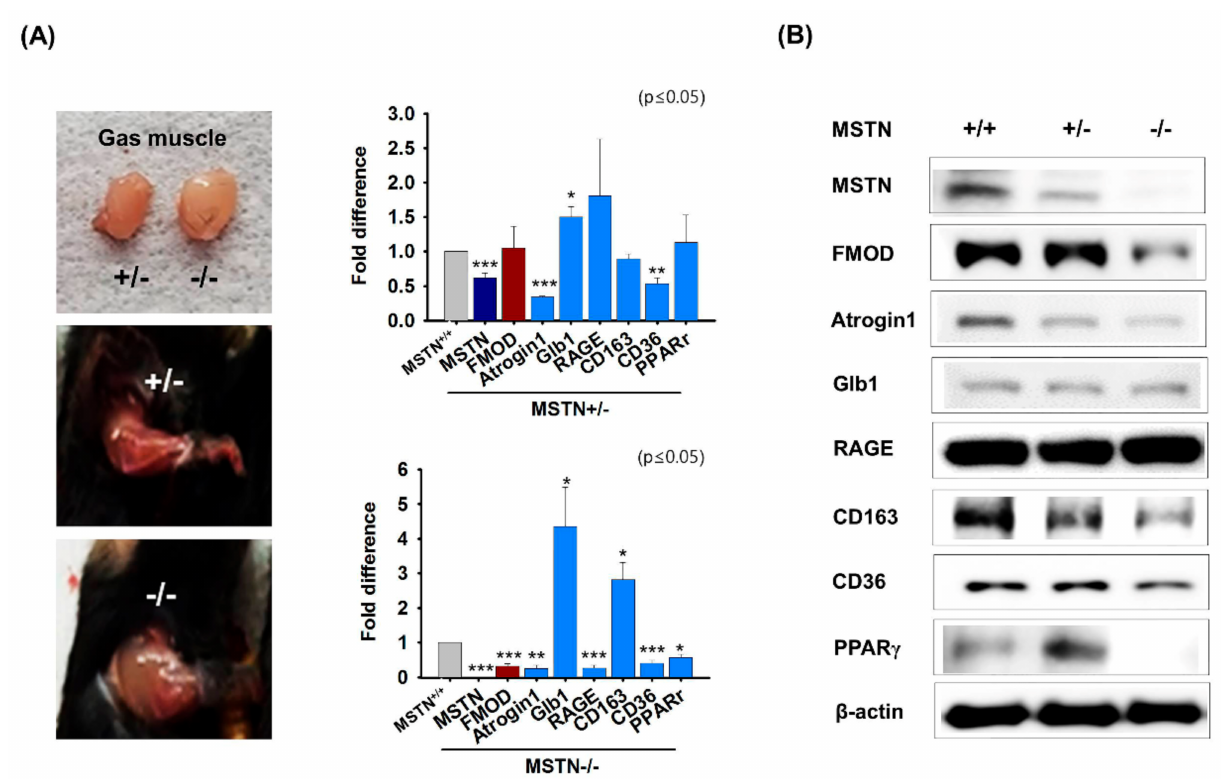
Figure 2. FMOD and MSTN expressions in MSTN − / − mouse muscles. ( A , B ) mRNA and protein expressions were determined by real-time RT-PCR and Western blot in MSTN +/+ , MSTN +/ − , and MSTN − / − muscles. MSTN +/+ , MSTN +/ − , and MSTN − / − indicates the wild type, heterozygote, and homozygote, respectively. Means ± SD (n > 3). * p ≤ 0.05, ** p ≤ 0.001, *** p ≤